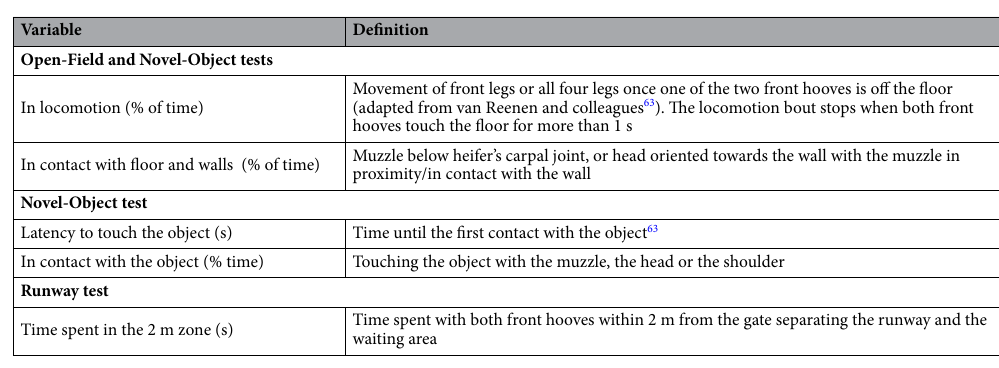
Table 7. Definitions of the behavioural measures recorded or live scored across the three personality tests.